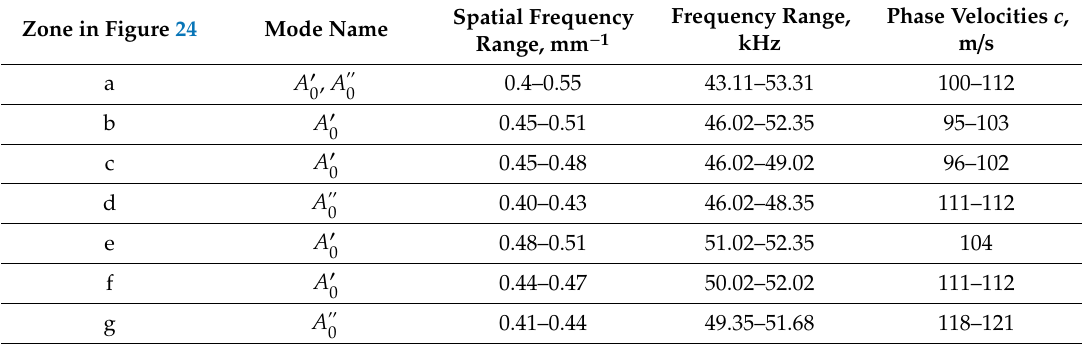
Table 1. Phase velocities of di ff erent